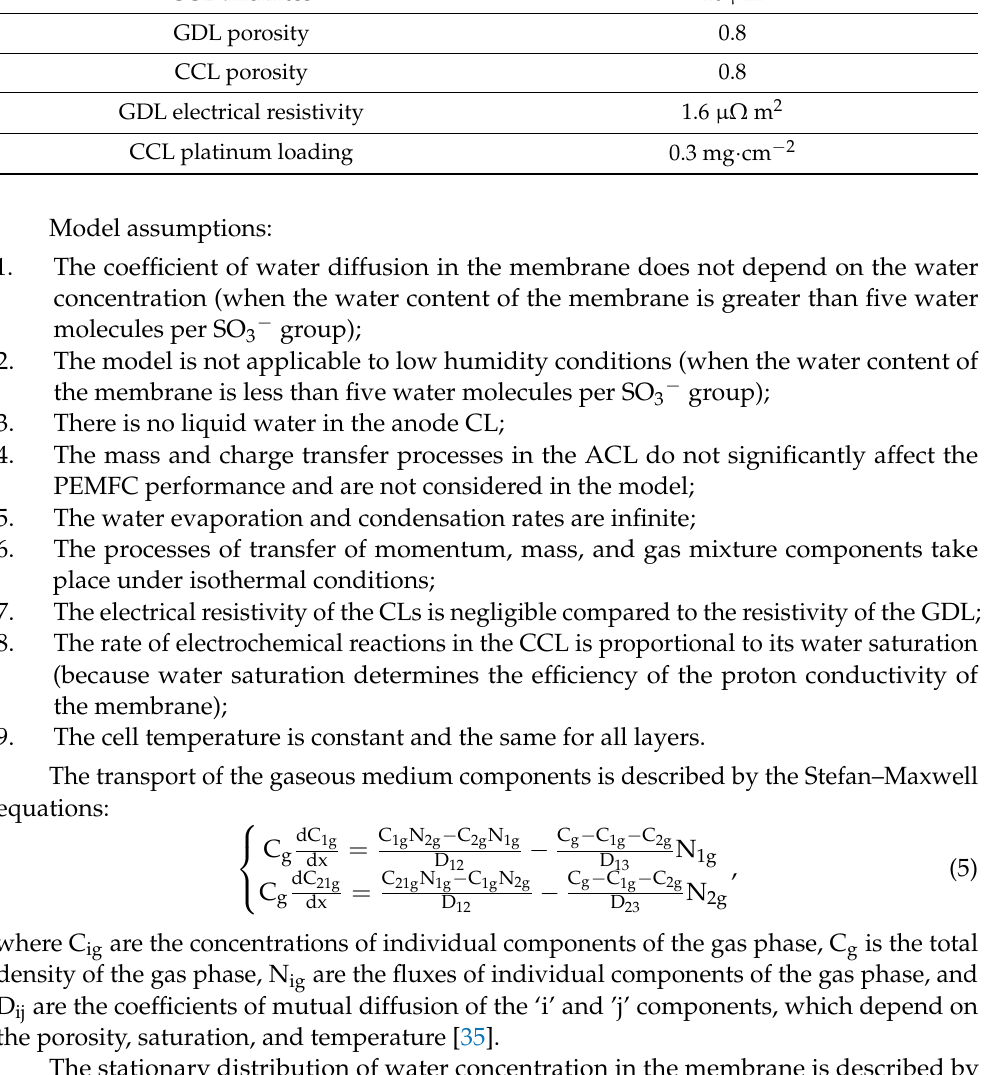
Table 3. Initial parameters of the PEMFC model with CNT-based CCL. Parameters Values Cell temperature 30 ◦ C Gas pressure on the anode and cathode